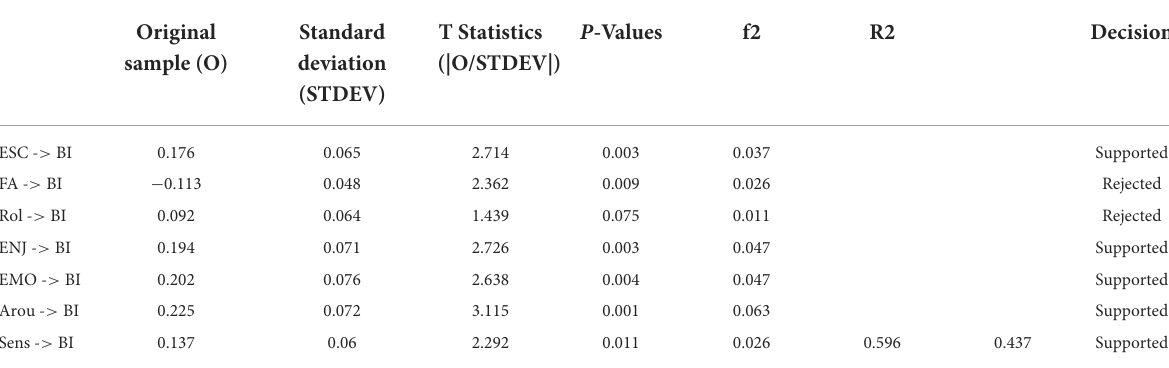
TABLE 4 Structural model